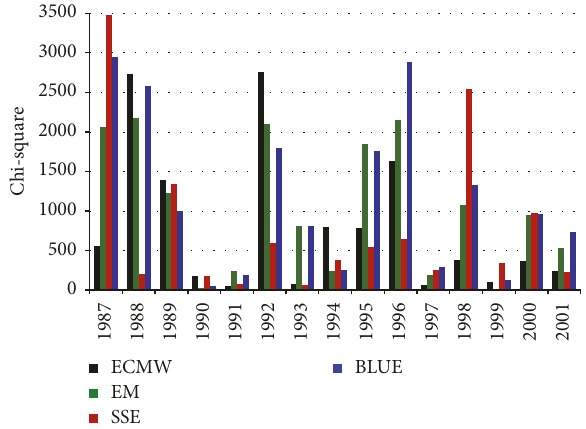
Figure 3: 𝜒 2 values for measuring association between observed rainfall and rainfall over Indian region (69–92E, 8–30N) from ECMWF, EM, superensemble scheme, and BLUE for JJAS seasonal rainfall anomaly predictions for threshold of − 1mm/day.